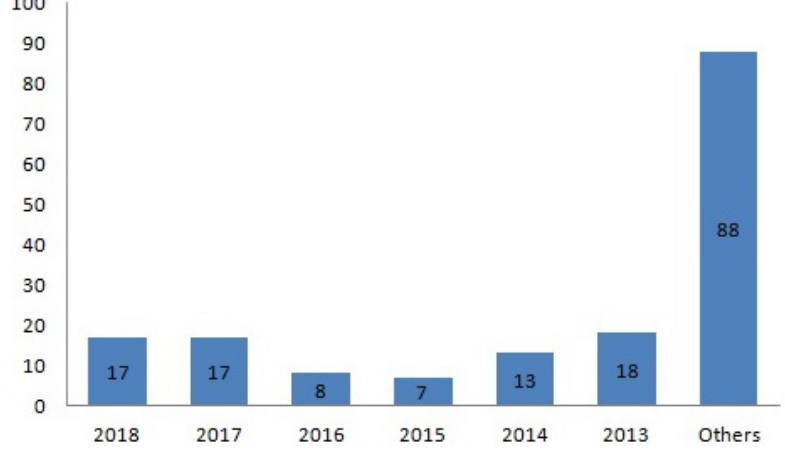
Figure 3. Annual publication year-wise